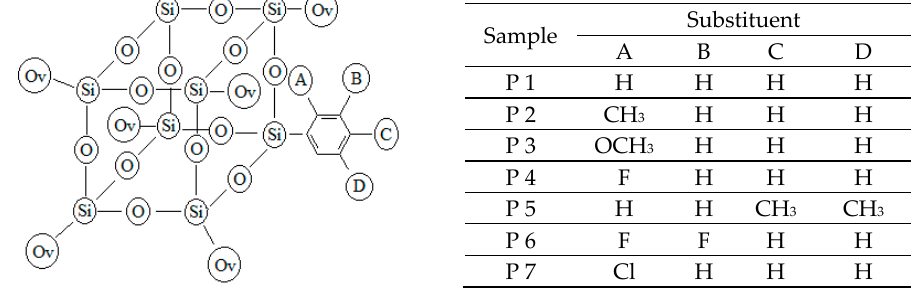
Figure 1. The structures of POSS powders modified by the substitution of outer phenyl unit. The γ -exposure was accomplished in an irradiator provided with a 60 Co source (Ob Servo Sanguis, Hungary) at room temperature. The dose rate was 0.6 kGy h − 1 during the sample γ -processing by rotating of support can in the irradiation room. The selected doses were 0, 25, 50 and 100 kGy.